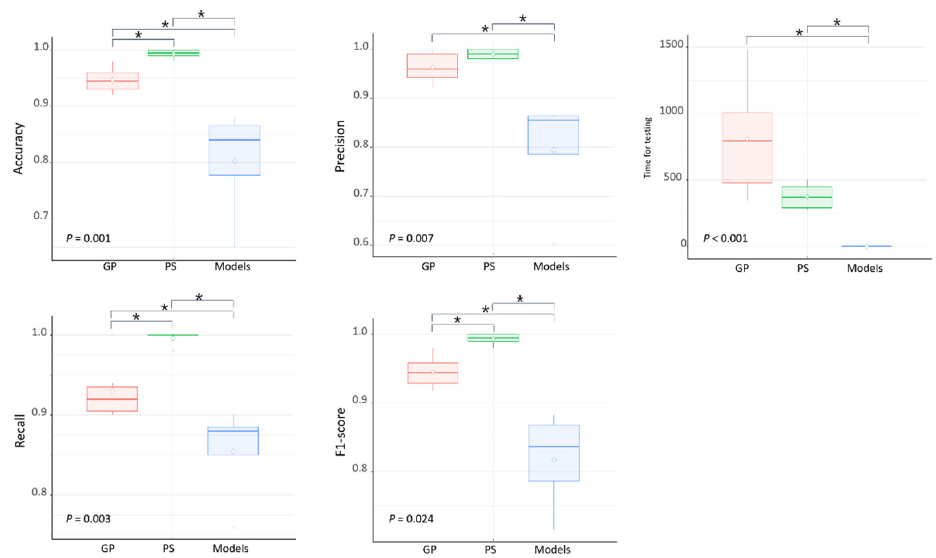
Table 4. Comparison of diagnostic performances of deep-learning models and human groups.